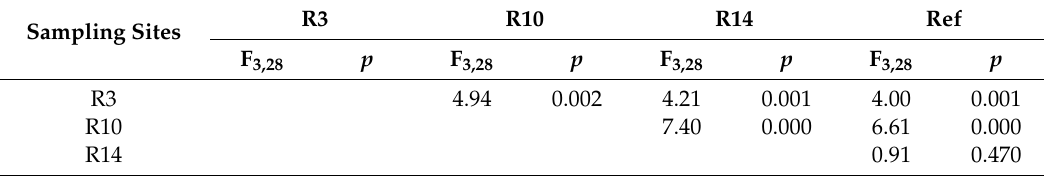
Table 2. F- and p -values of a one-way PERMANOVA test on nematode community data to check for similarities in community composition between landfill sections and the adjacent reference